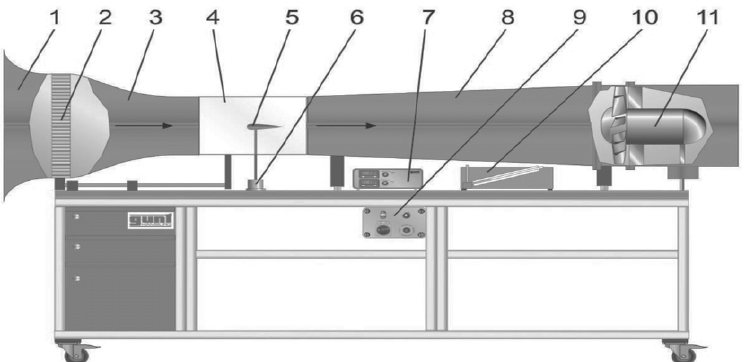
Figure 2. Structure of the HM 170 tunnel: 1—inlet; 2—air flow straightener; 3—nozzle (confusor); 4—measurement chamber; 5—tested model; 6—force-measuring sensor (scale); 7—measurement system with display; 8—diffuser; 9—control panel; 10—manometer with inclined tube for speed reading; 11—fan.